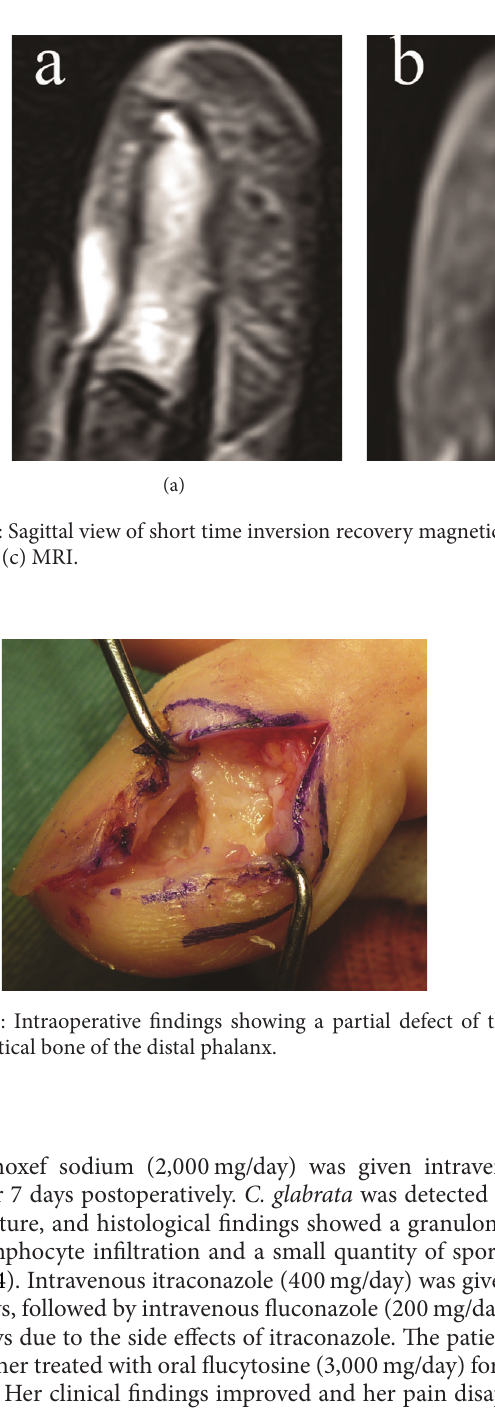
Figure 1: Anteroposterior and lateral radiographs at the first presentation.